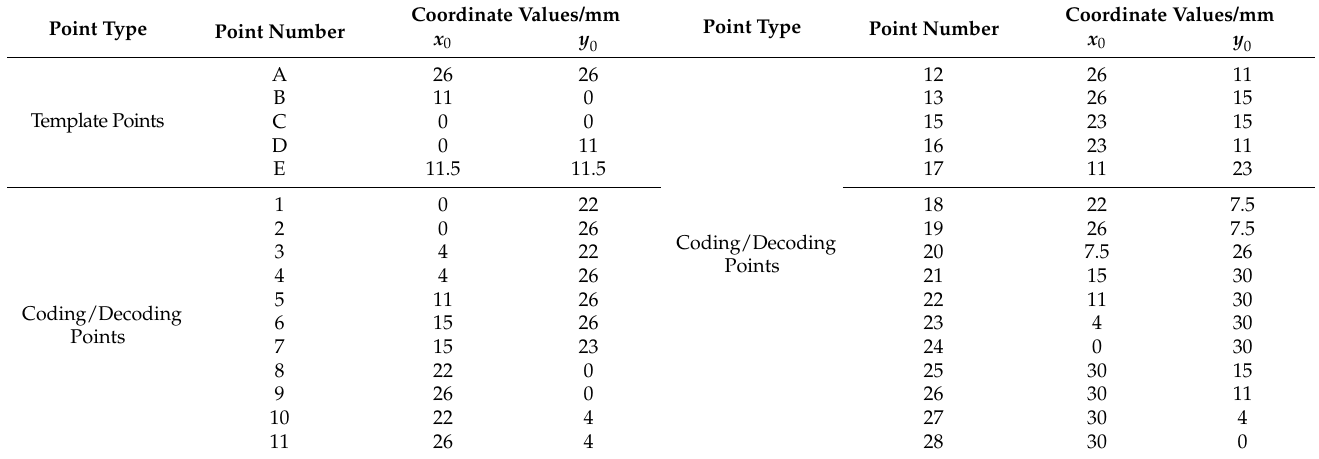
Table 1. Designed coordinate values of GCTs.